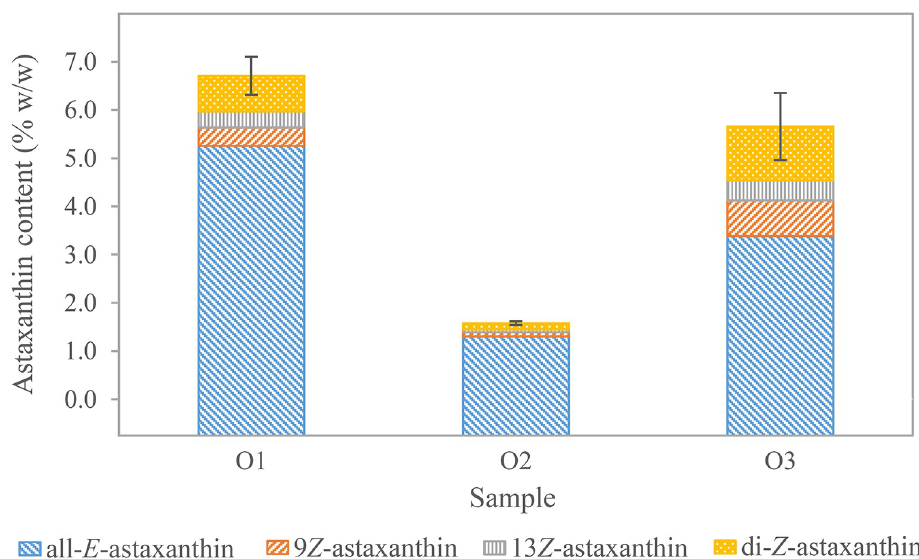
Fig 8. Astaxanthin content of three different oleoresins of H . pluvialis . Standard deviations are indicated for total astaxanthin. O1 (n = 3) and O3 (n = 3) derive from different batches. O2 (n = 7) is a dilution of O1. Standard deviations for the individual isomers can be found in S1